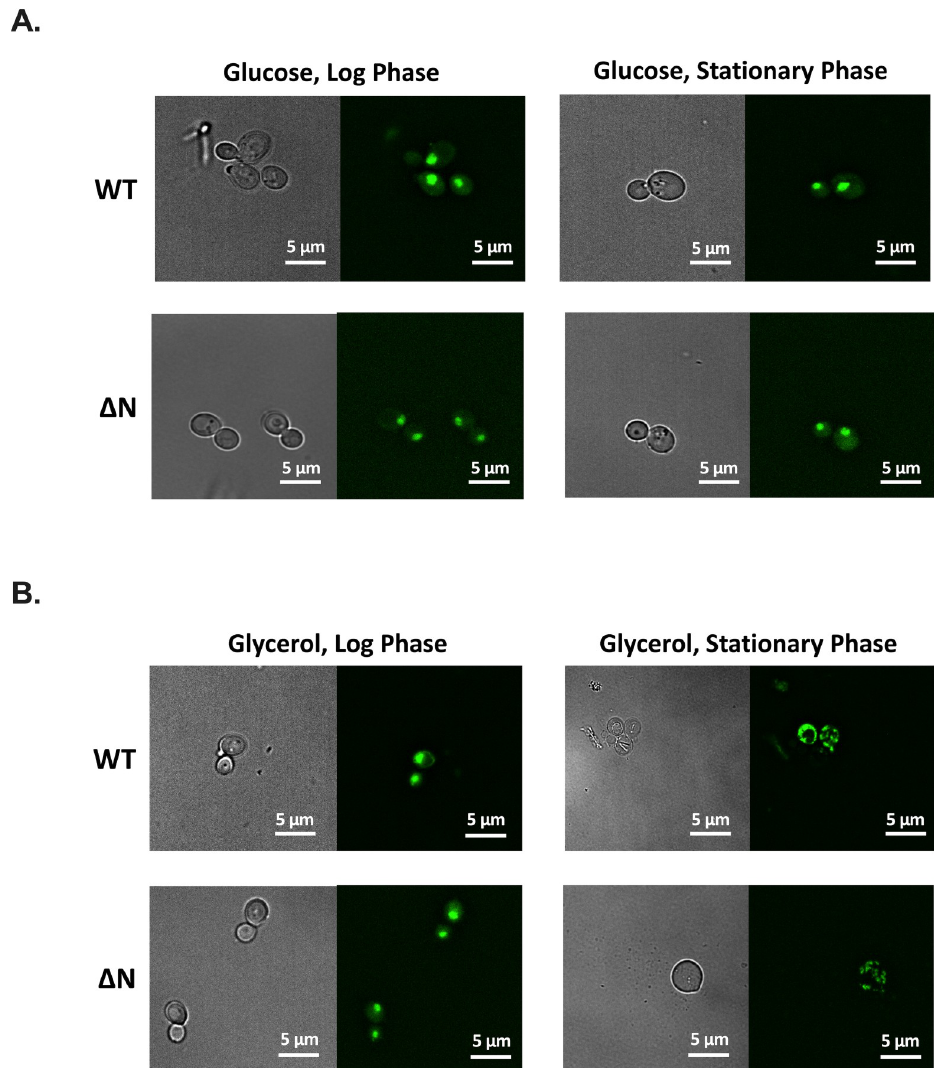
Fig 4. Role of the polyN domain in localization of Azf1p. A) Representative images of localization of Azf1p in glucose during growth in log and stationary phase. During growth in glucose, Azf1p is localized to the nucleus. B) Representative images of localization of Azfp1 during growth in glycerol in log and stationary phase. During log phase, Azf1p is localized to the nucleus. During stationary phase, both Azf1p and Azf1- Δ Np form cytoplasmic foci. At least 50 cells were imaged for each strain in each